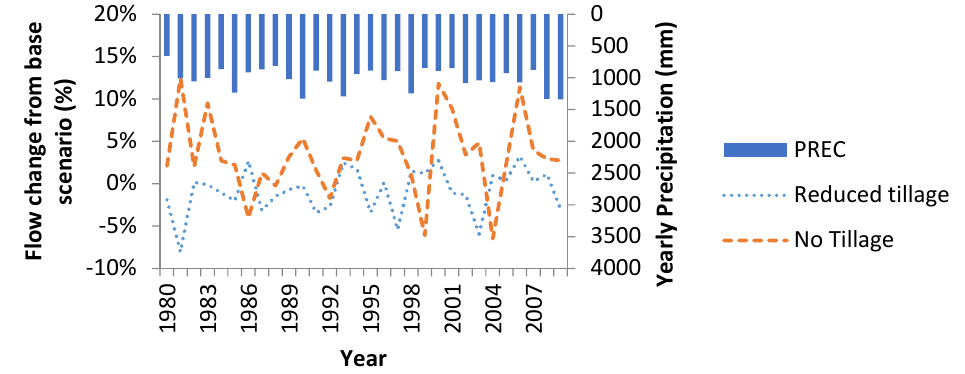
Figure 4. Change in outlet flow for different tillage practices compared to conventional tillage on annual basis (1980–2009).